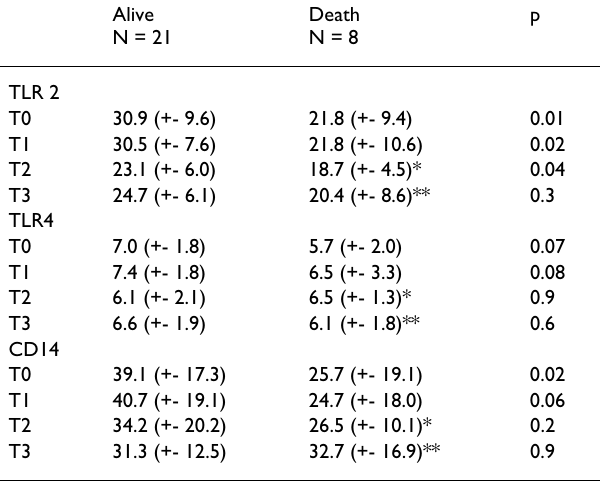
Table 2: TLR and CD14 protein expression on monocytes of patients with sepsis according to survival. Alive N =